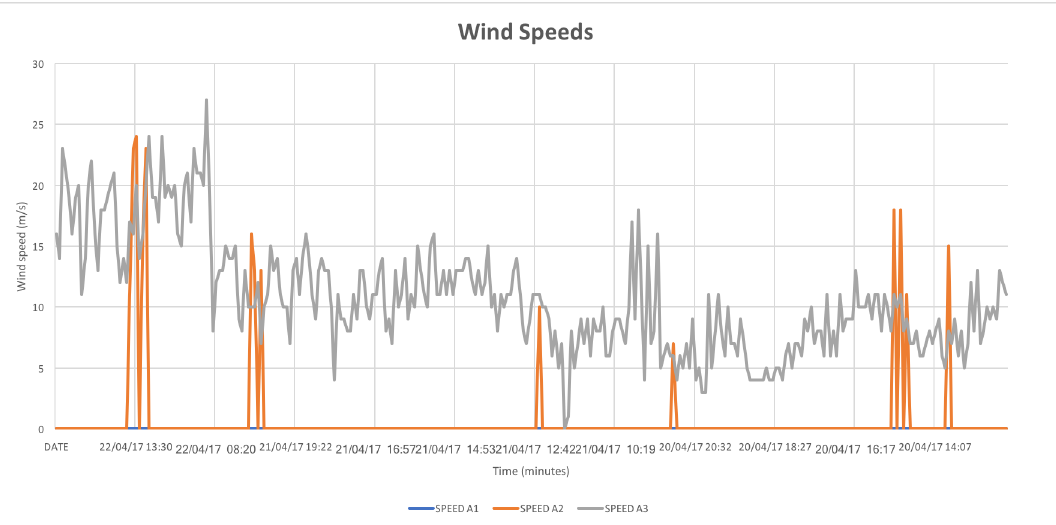
Figure 11. Wind speed measured by the three anemometers during the data acquisition campaign carried out on the beach of Marina di Tirrenia. A1 is the lower anemometer placed at 120 cm height, A2 is the middle anemometer placed at 200 cm and the A3 is the higher one placed at 280